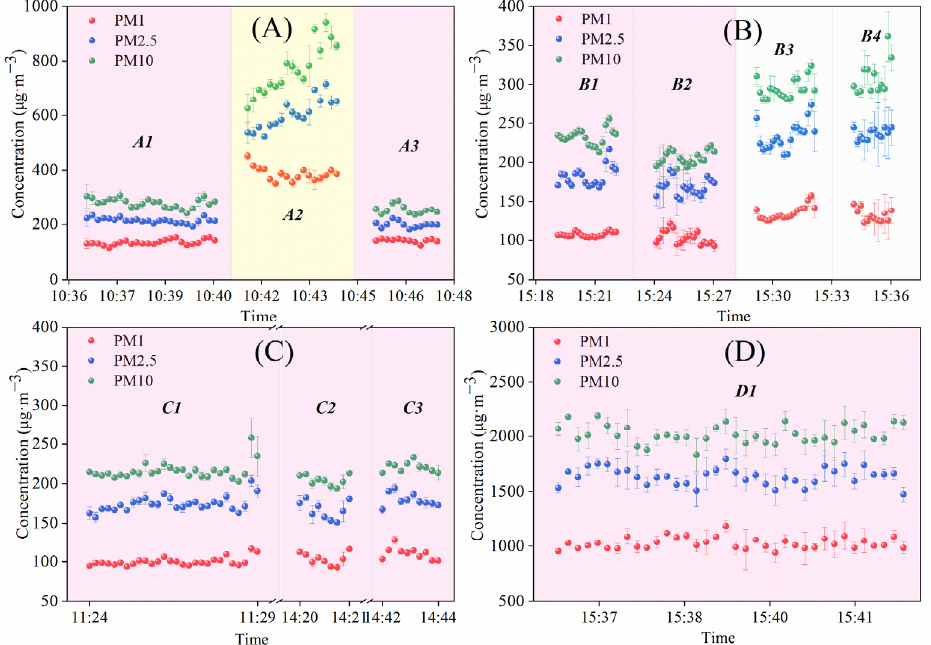
Figure 9. Measurement results of PM concentration in the plumes of four textile dyeing enterprises on 30 (( C , D ) enterprise) and 31 (( A , B ) enterprise) January 2021. A1–A3 represented the number of chimneys in A enterprise. Similarly, B1–B4, C1–C3, and D1 meant the number of chimneys in B, C, and D enterprise, respectively. The background color represented various productions, including dyeing process (pink), pigment printing (yellow), and digital printing (gray) in the four textile dyeing enterprises.